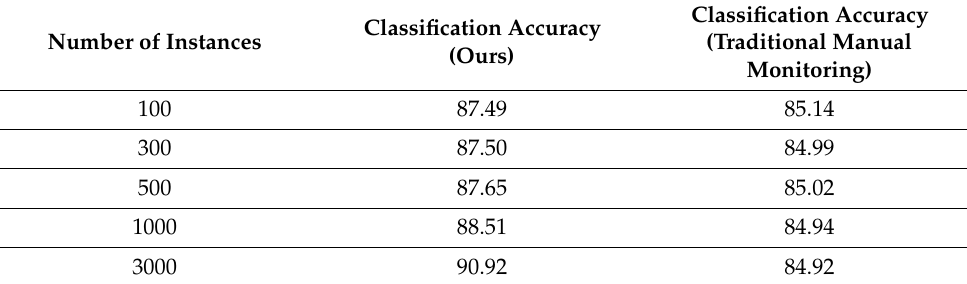
Table 1. Accuracy experimental